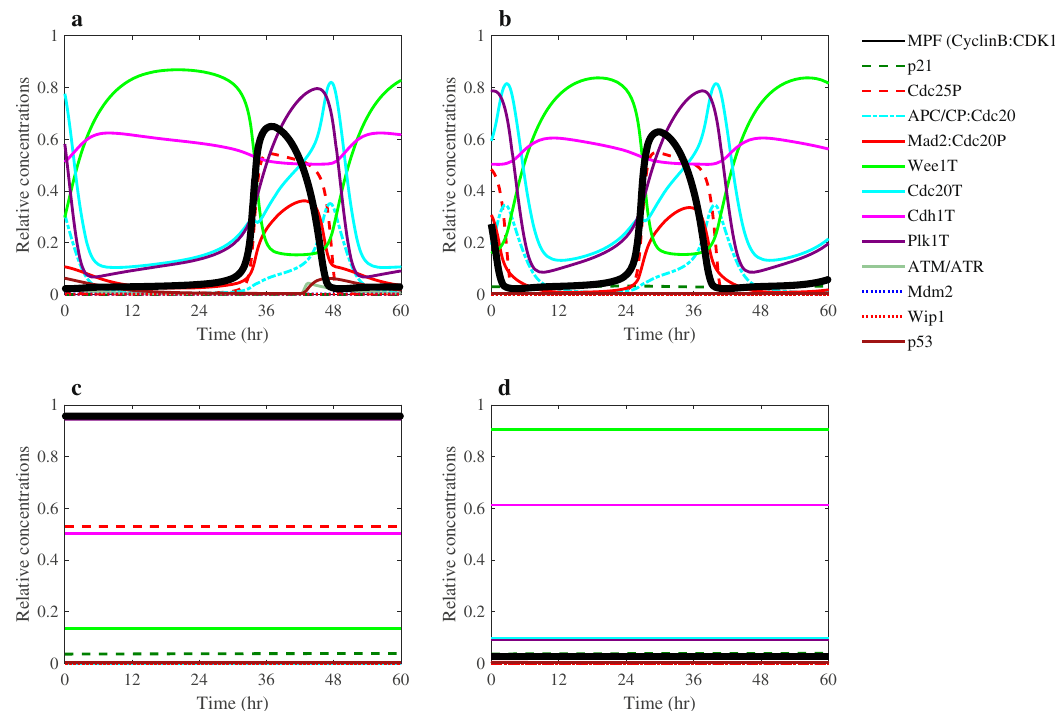
Fig. 7 Dynamic behavior of cell cycle regulators in mutants. a CDKN1A gene deletion mutant is viable. b PTTG1 gene deletion mutant is viable with cell cycle comparable to that in wild-type cells (see Table 1). c CDC20 gene deletion mutant shows M-phase cell cycle arrest with high level of MPF. d CDC25 gene deletion induces early cell cycle arrest with low level of